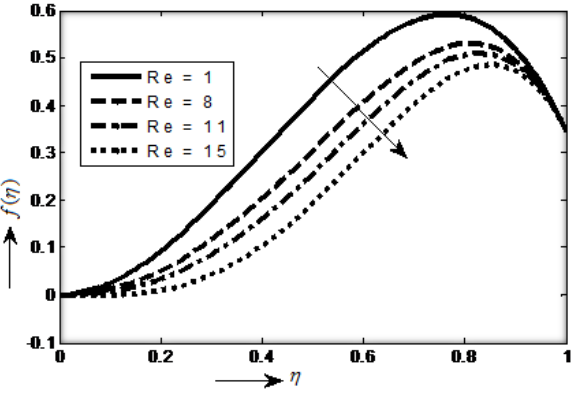
Figure 4. Variation of fluid velocity f (  ) with respect to  for Reynolds Numbers Re (1, 8, 11, 15) by taking parameters M = 2, K = 0.8 and  =0.05